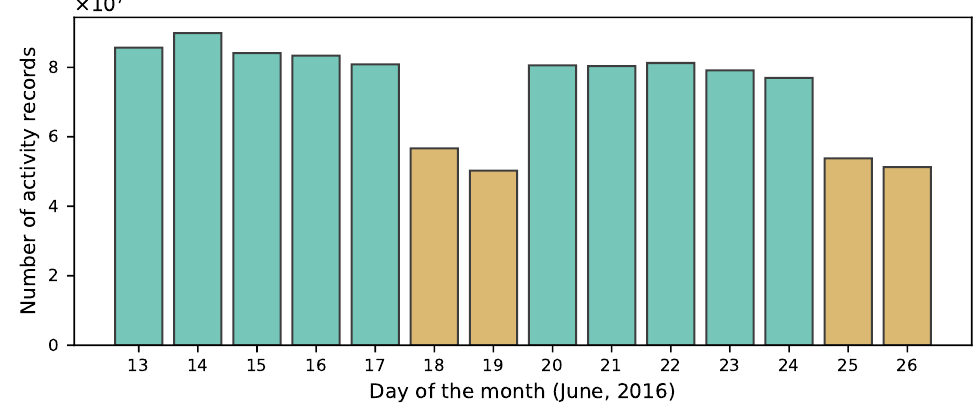
Figure 4. Number of daily activity records during two weeks of June 2016. The matches of the Hungarian national football team took place from 14 June to 26